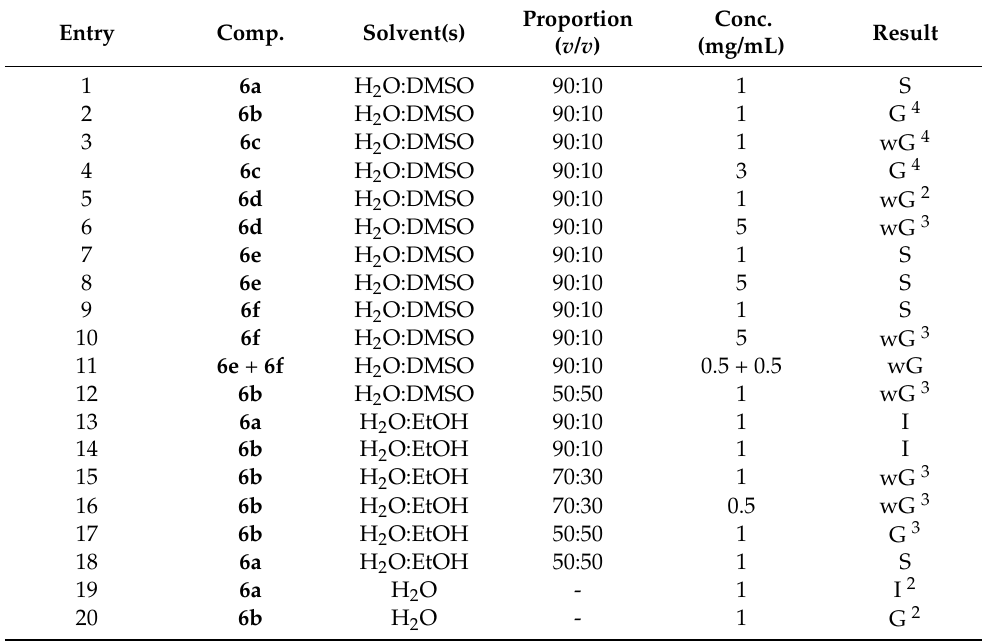
Proportion Conc. ( v / v )